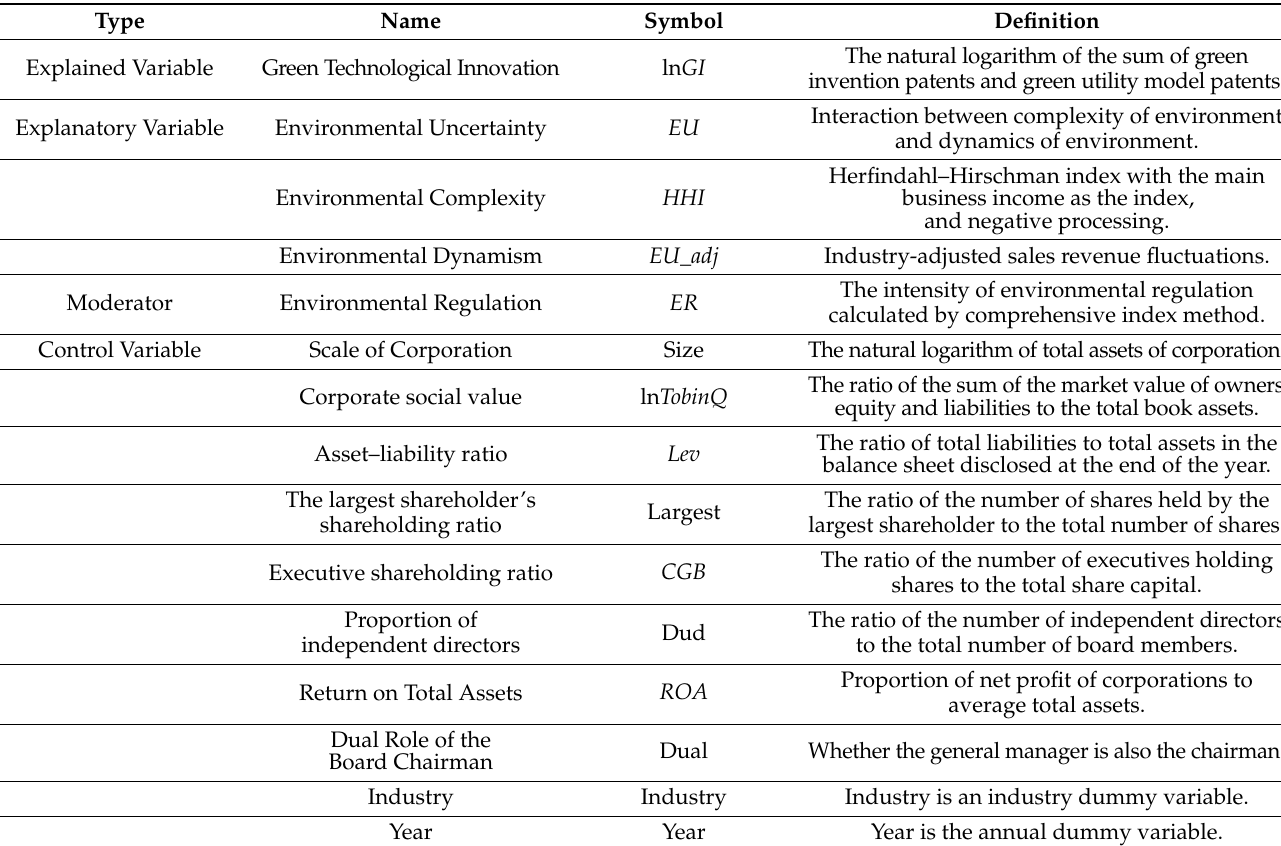
Table 1. Definition of Main